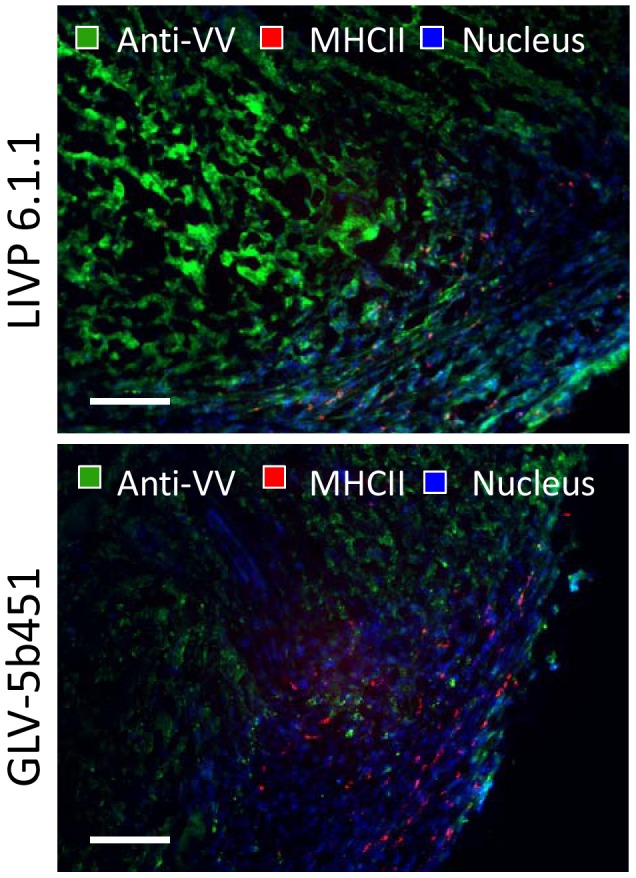
Immunohistochemical staining of either LIVP 6.1.1- or GLV-5b451-treated DT09/06 xenograft tumors at 28 dpvi.Representative tumor sections labeled with anti-vaccinia virus (green), anti-MHCII antibodies (red) and Hoechst 33342 staining (blue). Scale bars: 200 µm.